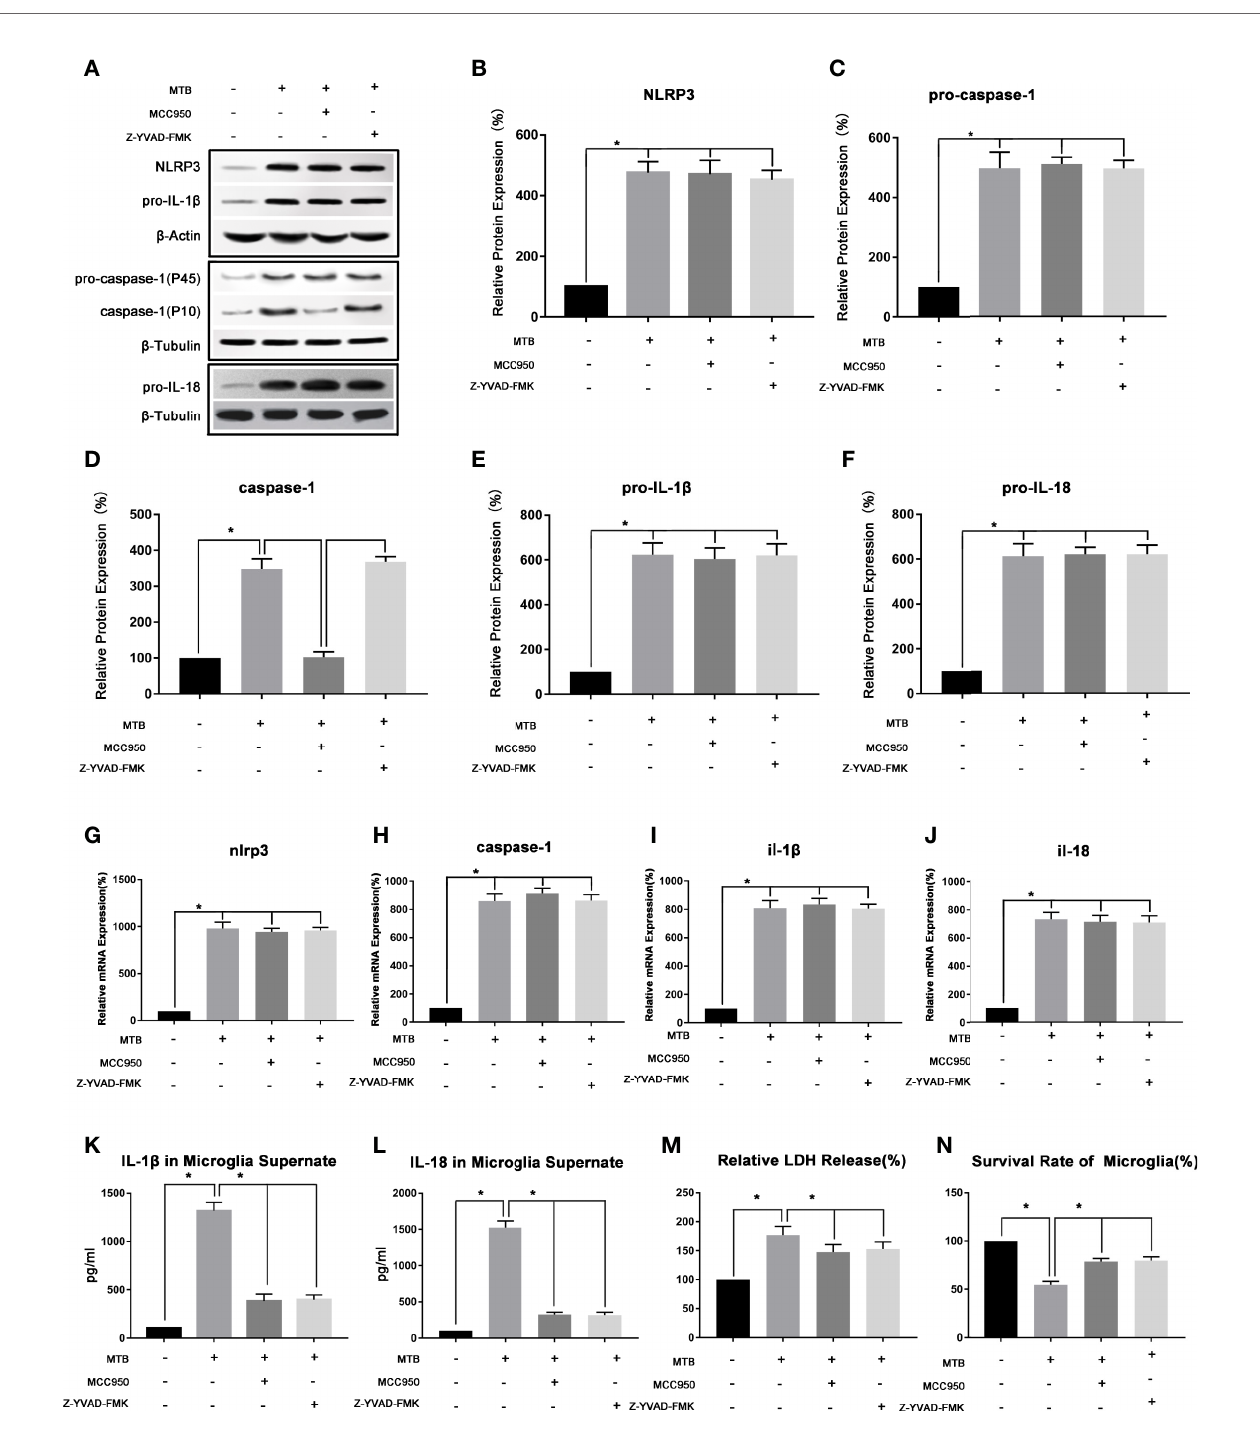
FIGURE 2 | Observe the changes of NLRP3 in fl ammasome of microglia in the co-culture model. (A – F) Use Western Blot to detect the relative protein expression of NLRP3, pro-caspase-1, caspase-1, pro-IL-1 b and pro-IL-18 in control group, co-culture group, MCC950 group and Z-YVAD-FMK group. (G – J) Use Real-time PCR to detect the relative mRNA expression of nlrp3, caspase-1, il-1 b and il-18 in control group, co-culture group, MCC950 group and Z-YVAD-FMK group. (K, L) Use ELISA to detect the IL-1 b and IL-18 secretion in supernatant of control group, co-culture group, MCC950 group and Z-YVAD-FMK group. (M) Use LDH release to measure the cytotoxicity in control group, co-culture group, MCC950 group and Z-YVAD-FMK group. (N) Use MTT analysis to detect the cell survival rate in control group, co-culture group, MCC950 group and Z-YVAD-FMK group. *P <